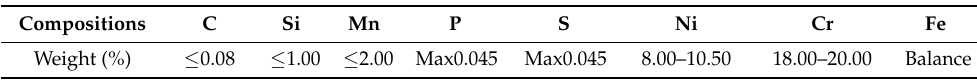
Table 1. SUS304’s chemical compositions (JIS